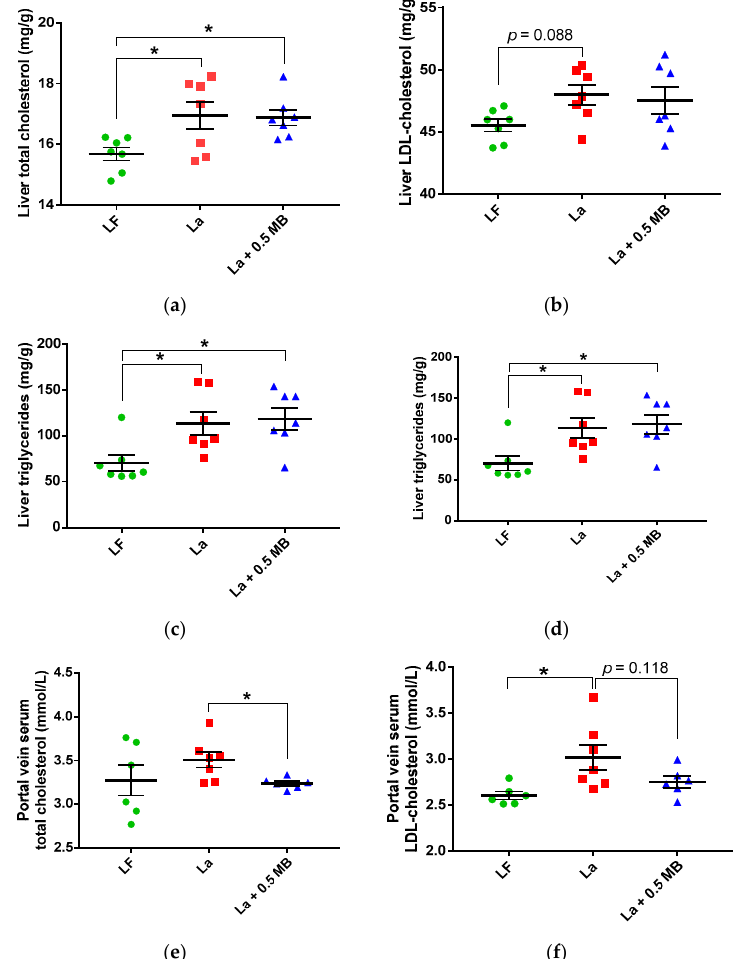
Figure 5. Lipid profiles in rats fed a low-fat (LF) diet, a high-fat control diet based on lard (La), or the same La diet supplemented with 0.5 MB g/100 g (dry weight basis) (La + 0.5 MB) for 4 weeks. ( a ) Liver total cholesterol (mg/g, p ANOVA = 0.0116, one-way ANOVA and post-hoc Dunnett’s test), ( b ) liver LDL-cholesterol (mg/g, p ANOVA = 0.1092, one-way ANOVA and post-hoc Dunnett’s test), ( c ) liver triglycerides (mg/g, p ANOVA = 0.0116, one-way ANOVA and post-hoc Dunnett’s test), ( d ) total amount of liver HDL-cholesterol (mg, p ANOVA = 0.04, one-way ANOVA and post-hoc Dunnett’s test) ( e ) portal vein serum total cholesterol (mmol/L, p < 0.05, unpaired, 2-tailed t -test), ( f ) portal vein serum LDL-cholesterol (mmol/L, p < 0.05, unpaired, 2-tailed t -test). Values are means ± SEM. Mean values were significantly different between groups: * p < 0.05. LDL-cholesterol, low-density lipoprotein-cholesterol; HDL-cholesterol, high-density lipoprotein-cholesterol.